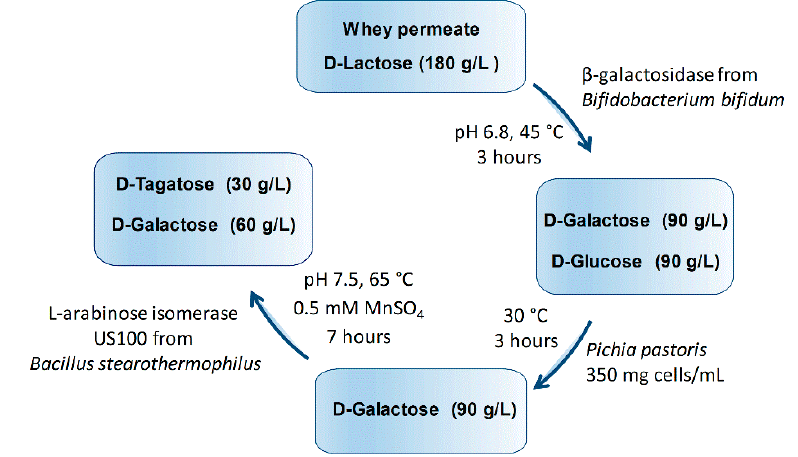
Figure 8. Scheme of the integrated process for bioconversion of whey permeate into D -tagatose syrup.